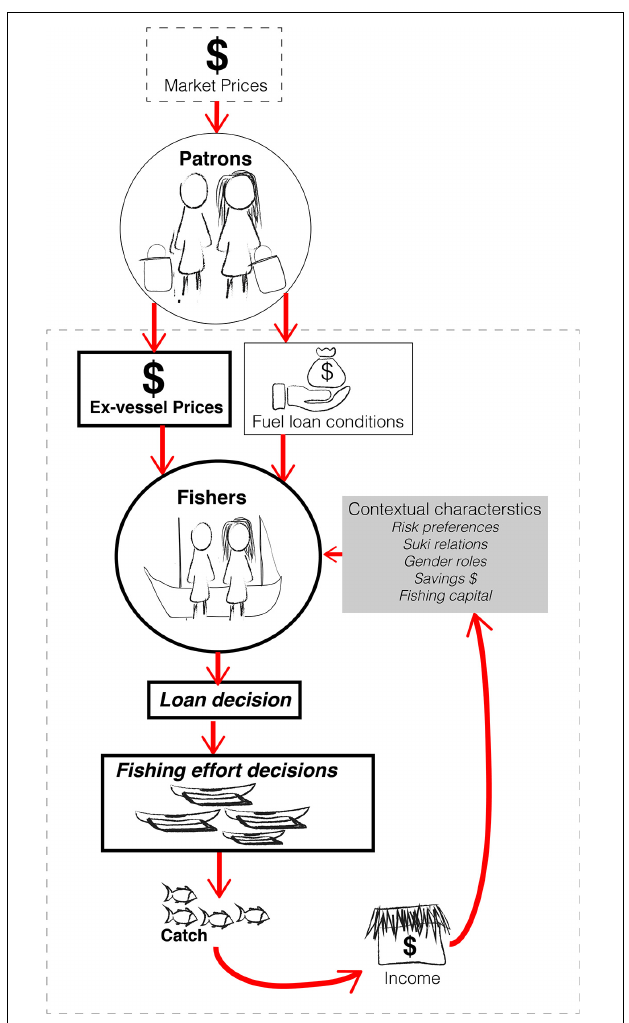
FIGURE 1 | Conceptual diagram of the study system and certain behaviors in focus. The diagram depicts the market prices being received by patrons, who based on this provide an ex-vessel price plus fuel loan conditions (i.e., size, pay back options) to fishers. Fishers then in turn make decisions about the loan and their fishing activities which translates into effort. This results in a catch and then an income, feeding back to their next trip, and related decisions. We highlight in the gray box the contextual characteristics that we hypothesize feed into fishers’